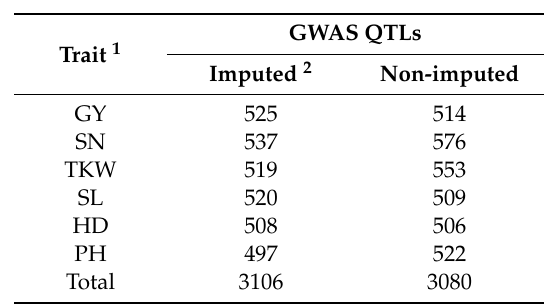
Table 5. The number of significant markers detected by genome-wide association studies (GWAS) under the imputed and non-imputed scenarios. Threshold of − log 10 P was set at